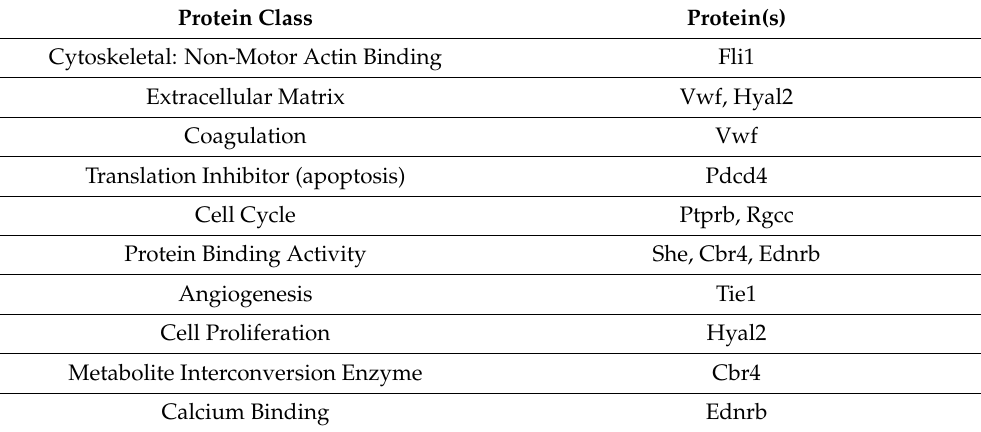
Table 3. The PANTHER/GeneCards classes of 10 of the proteins that have the highest level of downregulation compared to control at 24 h post cytomix treatment. As shown, most proteins are categorized within the protein binding activity, extracellular matrix and cell cycle classes and belong to multiple